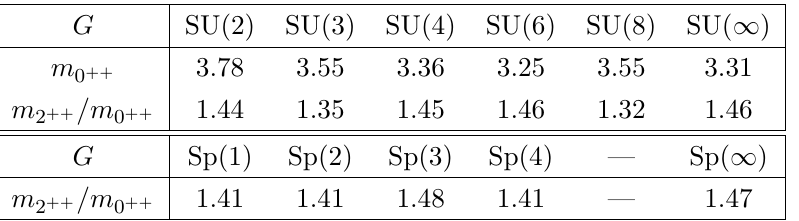
Table 1 . Lattice masses (in QCD string tension units [27]) and mass ratios of the 0 ++ and 2 ++ glueballs in the pure glue SU( N ) [23] and Sp( N ) theories [27].